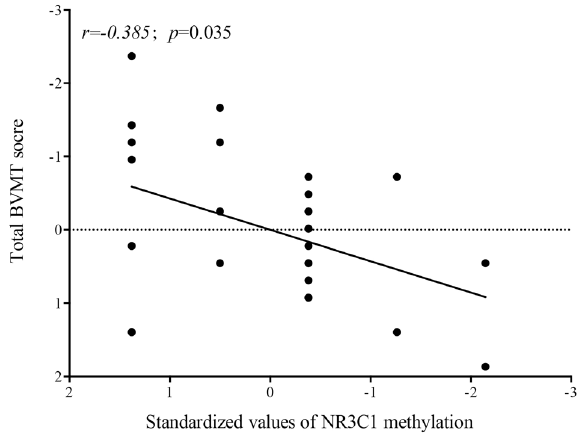
Fig. 5 A Spearman correlation analysis for correlating methylated CpG 1 of NR3C1 exon 1 F promoter and BVMT-R score in prenatal earthquake exposure group. A moderate negative correlation was found between methylated CpG1 site and BVMT-R scores only in the second trimester group. BVMT-R Brief Visuospatial Memory Test-